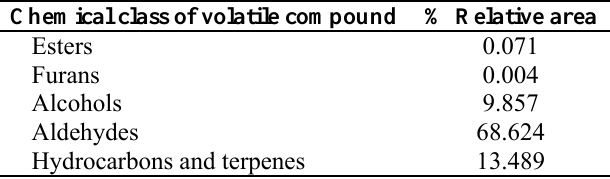
Table 4. Relative concentrations of several classes of volatile compounds in kesum.